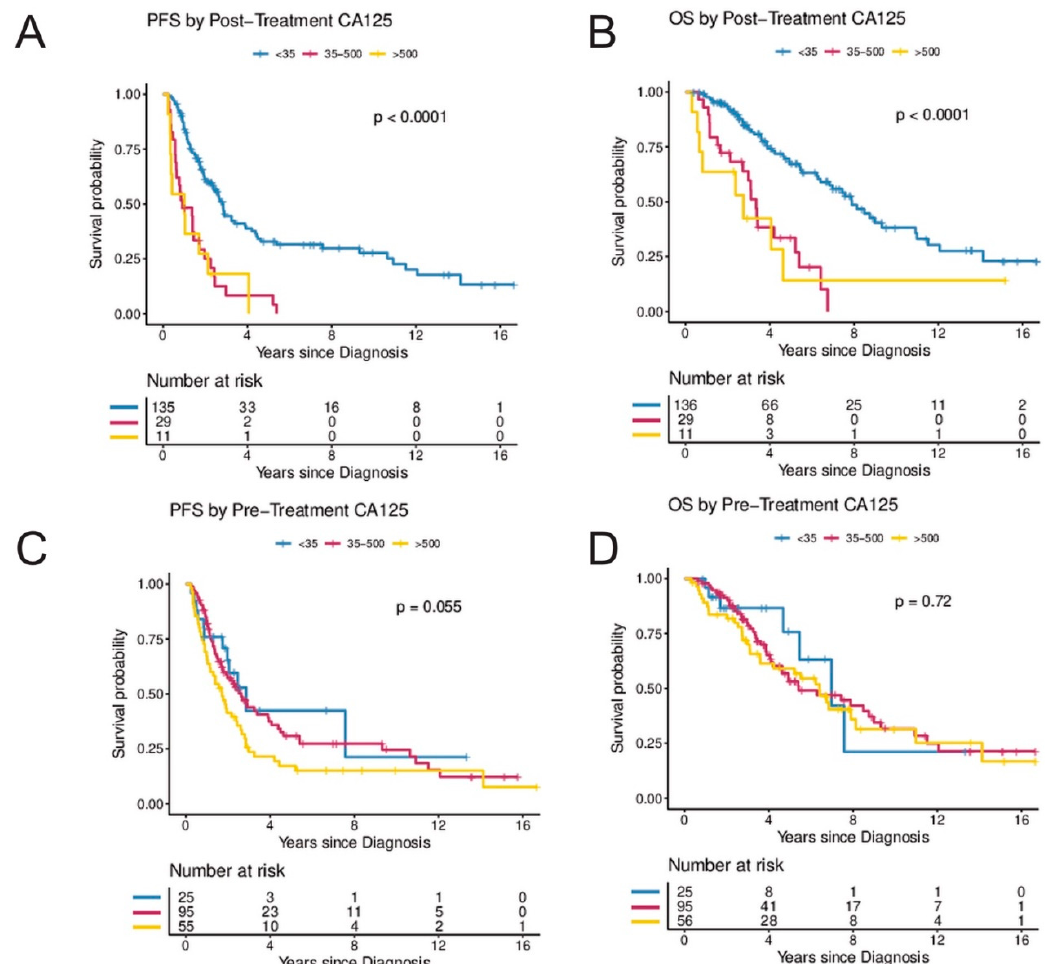
Figure 3. ( A – D ) Secondary analysis of post-treatment and pre-treatment CA-125 by CA-125 level. ( A , B ) illustrate progression-free and overall survival by CA-125 levels following treatment (<35 vs. 35–500 vs. >500) and ( C , D ) illustrate progression-free and overall survival by CA-125 levels at diagnosis (<35 vs. 35–500 vs. >500). The Kaplan–Meier method with log-rank tests was used to examine survival differences. p -values < 0.05 were considered statistically significant. Individuals at risk are shown in the legends. Abbreviations: OS, overall survival; PFS, progression-free survival.